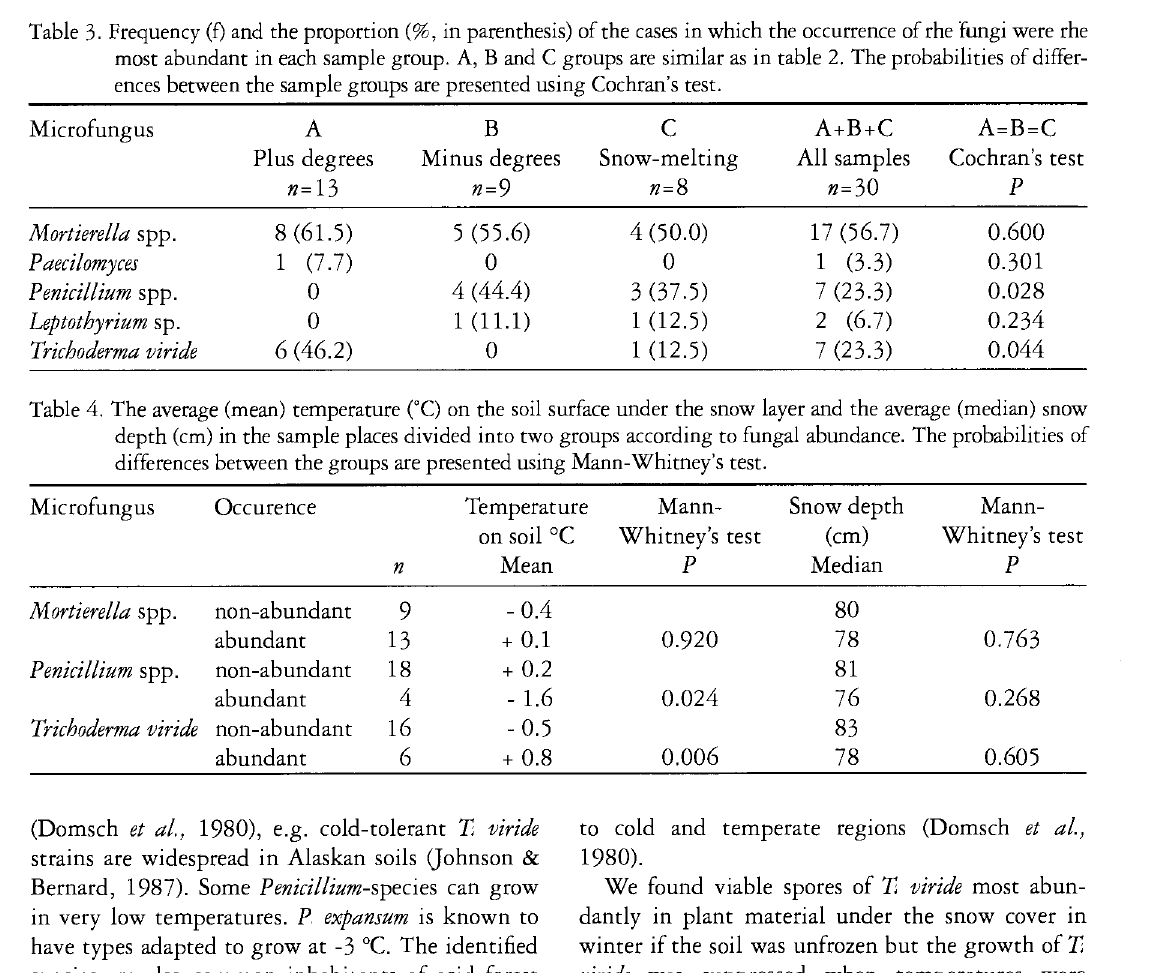
Table 3. Frequency (f) and the proportion (%, in parenthesis) of the cases in which the occurrence of rhe fungi were rhe most abundant in each sample group. A, B and C groups are similar as in table 2. The probabilities of differ ences between the sample groups are presented using Cochran's test.